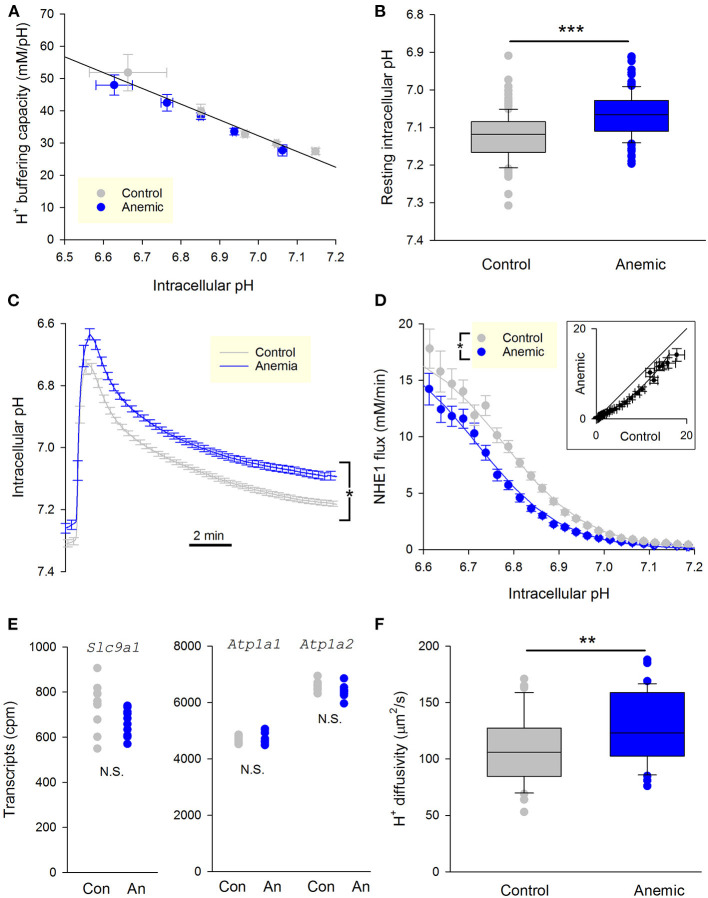
Chronic myocardial hypoxia in anemic animals persistently reduces NHE1 activity. (A) Intrinsic buffering capacity in myocytes from control (n = 20 cells, 3 mice) and anemic mice (n = 23 cells, 3 mice). No significant difference (two-way ANOVA). (B) Resting pHi under Hepes-buffering regime (n = 124 and 121 cells from 3 anemic and 3 control mice, respectively); t-test, P < 0.01. (C) Time course of pHi recovery following an ammonium prepulse. Average of 46 myocytes from three control hearts and 36 myocytes from three anemic hearts. Error bars not shown for clarity. (D) NHE1 generated flux in myocytes from control (n = 46 cells from 3 mice) and anemic (n = 36 cells from 3 mice) animals, showing significant decrease in the latter; two-way ANOVA: significant (P < 0.01) effect of anemic intervention. (E) Levels of transcripts for the gene coding NHE1, Slc9a1, is not different between anemic and control hearts. Whole heart tissue mRNA from 9 mice per group. Used as a control, Na+/K+ pump genes Atp1a1 and Atp1a2 are unchanged. (F) Apparent H+ diffusion coefficient is significantly increased in myocytes from anemic mice (n = 12 from 3 mice) relative to control myocytes (n = 12 from 3 mice); t-test, P < 0.01.